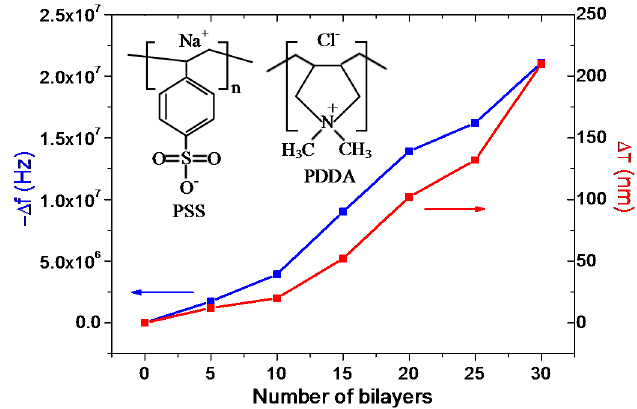
Figure 6. Frequency shift of FBAR and thickness growth of PSS/PDDA bilayers during the molecular surface self-assembly on NH 2 -functionalized FBAR.